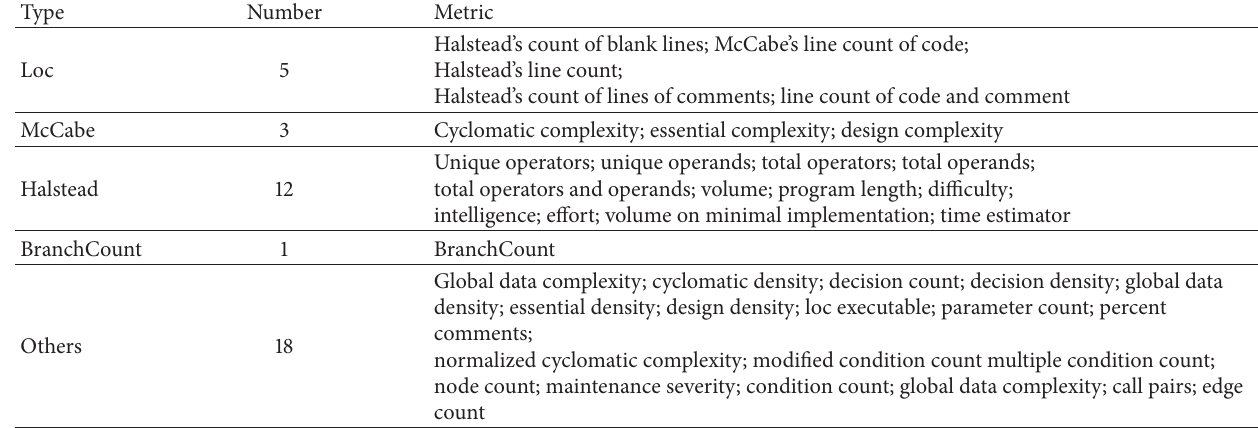
Table 2: Metrics used in our